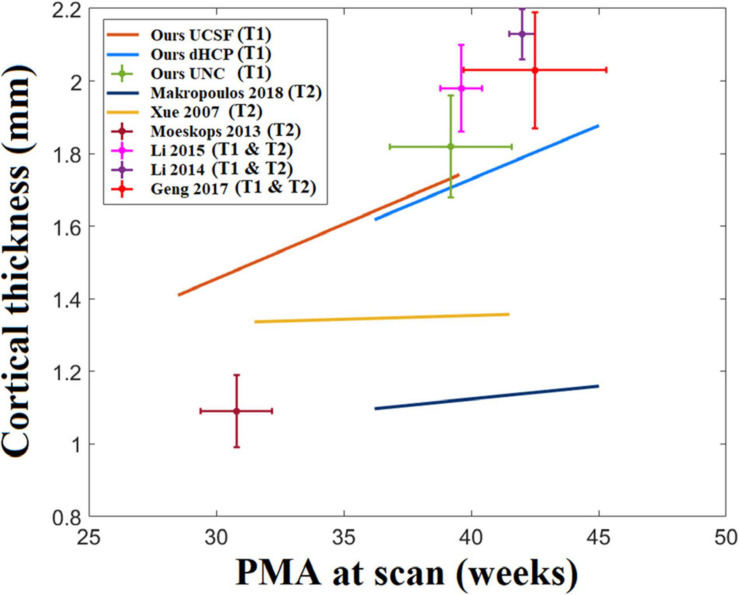
A statistic of neonatal cortical thickness measured from different studies. We consider the age range of the samples in each study and the growth trajectory. However, we found that the age ranges for some of the studies are very small. For example, Moeskops’s study only tested 10 subjects and the standard deviation of the age range is only 1 week. For those studies with relatively short age ranges (SD < 1.5 weeks), we indicate them with crosshairs that represent the two-standard deviation of the age range (horizontal extent) and cortical thickness (vertical extent). On the other hand, regression lines are used to represent the cortical thickness growth for those studies with larger age ranges (SD > 1.5 weeks).